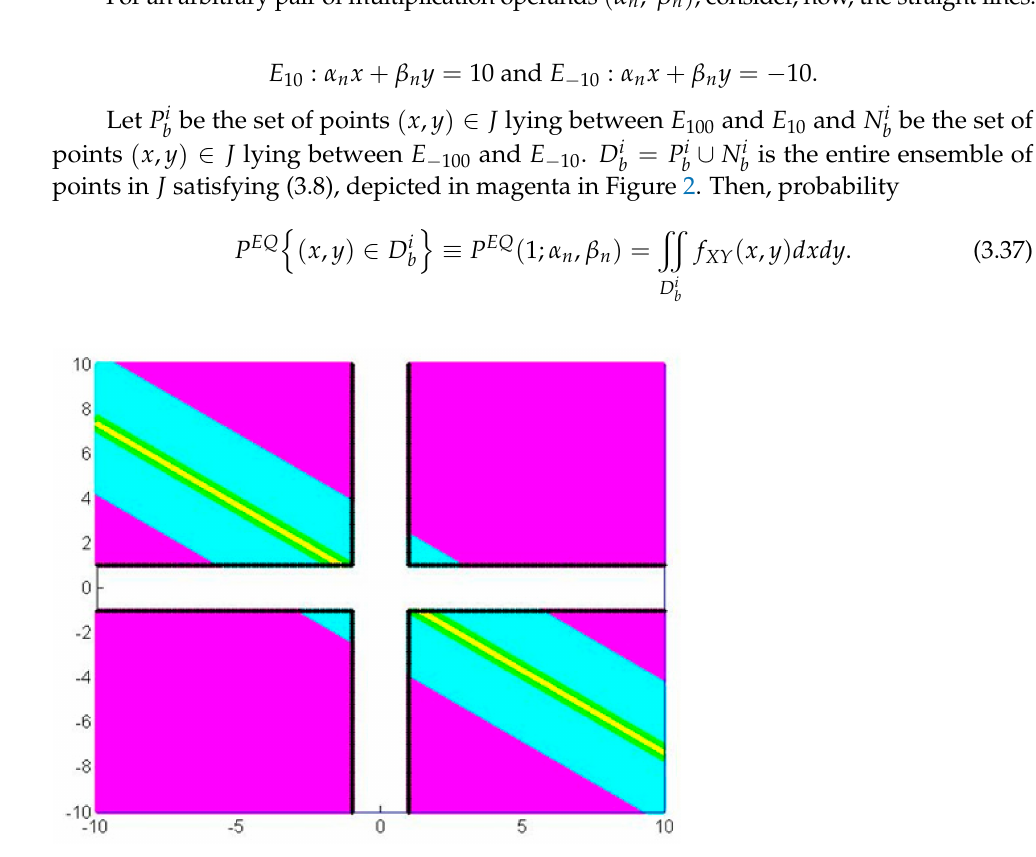
Figure 2. Depiction of the various sub-domains of J , which give rise to different numbers of erroneous decimal digits of γ 5 = α 5 β 5 , where | man ( α 5 ) man ( β 5 ) | < 10. In this example, we have selected α 5 = 2.3912 and β 5 = 3.2578; consequently: (a) the sub-region generating one additional e. d. d. is depicted in magenta, (b) the sub-domain that does not increase the f. p. error is shown in cyan (c) the sub-region relaxing the e. d. d. number by one is depicted in green and (d) the one relaxing the number of e. d. d. by two is shown in yellow. Sub-domains that represent an even greater relaxation of the f. p. e. are too small to